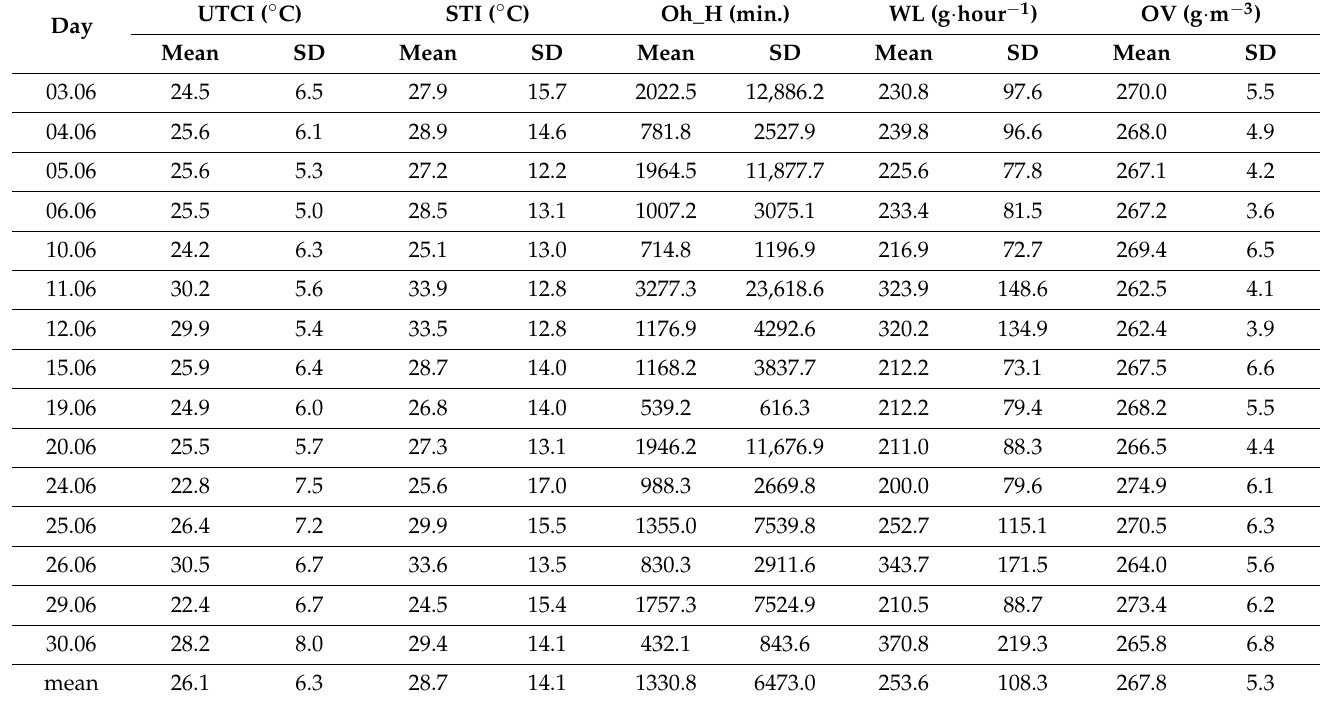
Table 5. Mean values and standard deviation: UTCI, STI, Oh_H, SW, and OV meaured in Bydgoszcz on hot days in June